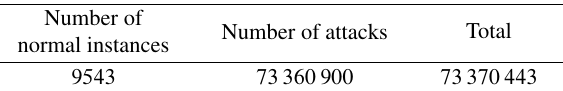
Details about Bot-IoT.